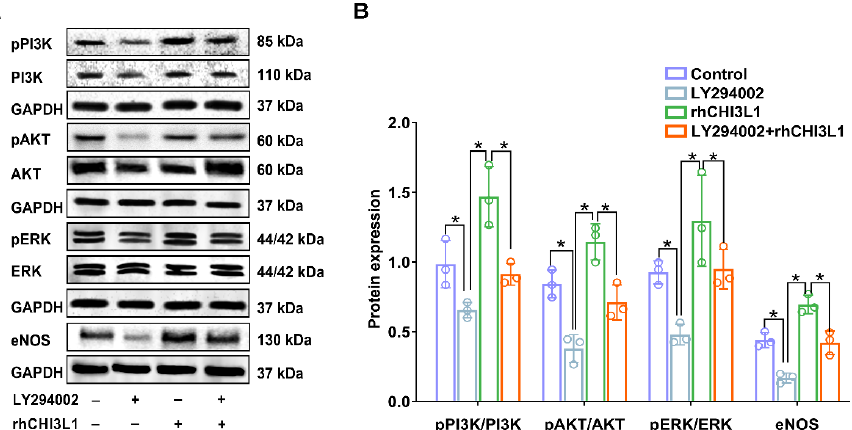
Figure 7. rhCHI3L1 promotes angiogenesis through the PI3K-AKT/ERK-eNOS signaling pathway in human umbilical vein endothelial cells (HUVEC). ( A ) Representative pictures of western blotting for detection of total and phosphorylated PI3K, AKT, ERK as well as eNOS protein expression in HUVEC. ( B ) Bar graph shows densitometric analysis of western blotting bands ( n = 3/group). Abbreviations: rhCHI3L1, recombined human chitinase-3-like protein 1; LY294002, 2-morpholino-8-phenyl-4H-chromen-4-one. Symbol * indicates p < 0.05 between the relevant groups.